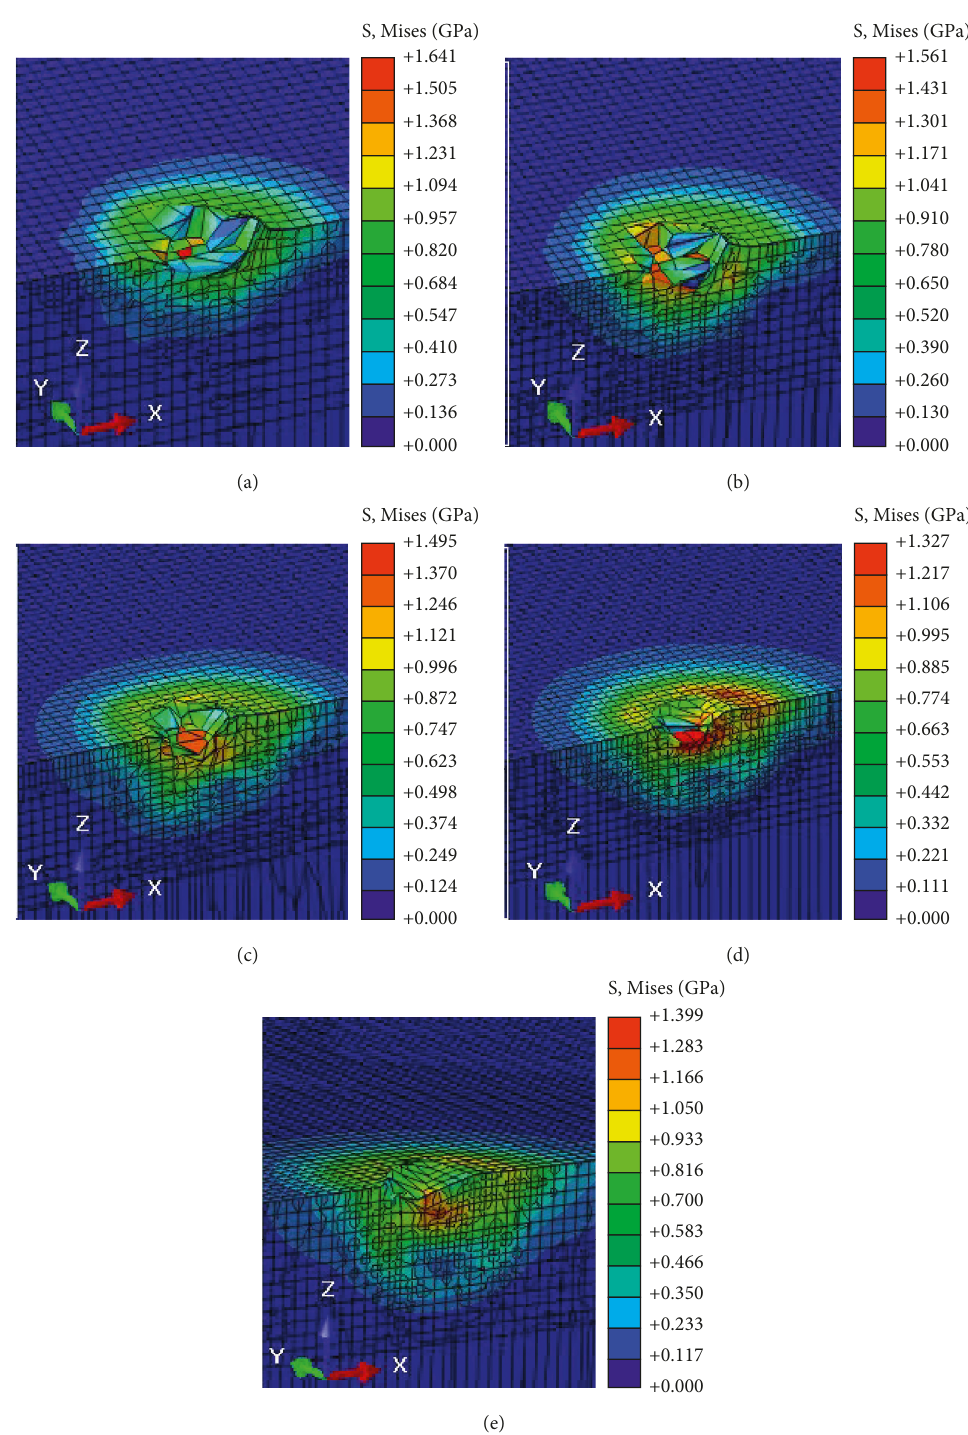
Figure 3: Erosion stress contour of the target material after repeated impacts at different impact angles. (a) 20 ° , (b) 30 ° , (c) 45 ° , (d) 60 ° , and (e) 90 °